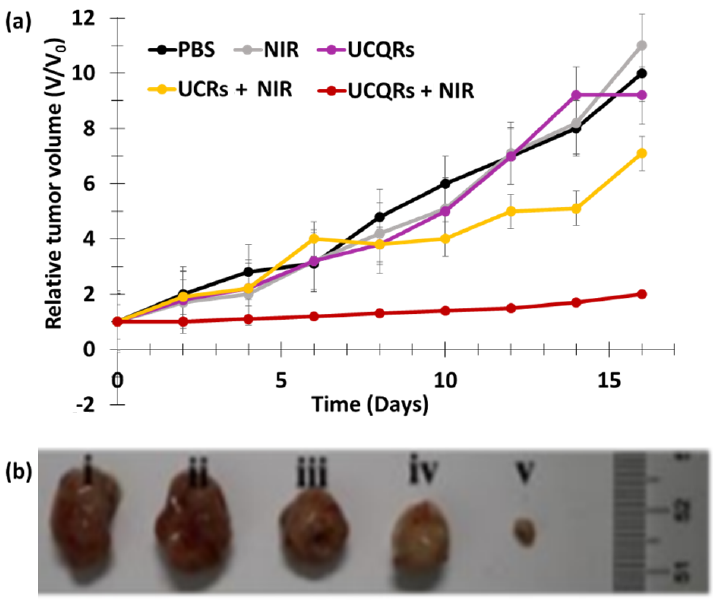
Figure 15. ( a ) Relative tumor volume obtained from mice with various treatments. ( b ) Representative photographs of the corresponding excised tumors (i—PBS, ii—NIR, iii—UCQRs (10 mg/mL, 40 µL), iv—UCRs + NIR (10 mg/mL, 40 µL), and v—UCQRs + NIR) (10 mg/mL, 40 µL). NIR irradiation (808 nm, 1.6 W/cm 2 , 10 min). Figure ( a ) adapted from Song et al. [37]. Figure ( b ) reprinted from Song et al. [37]. Copyright 2019 American Chemical